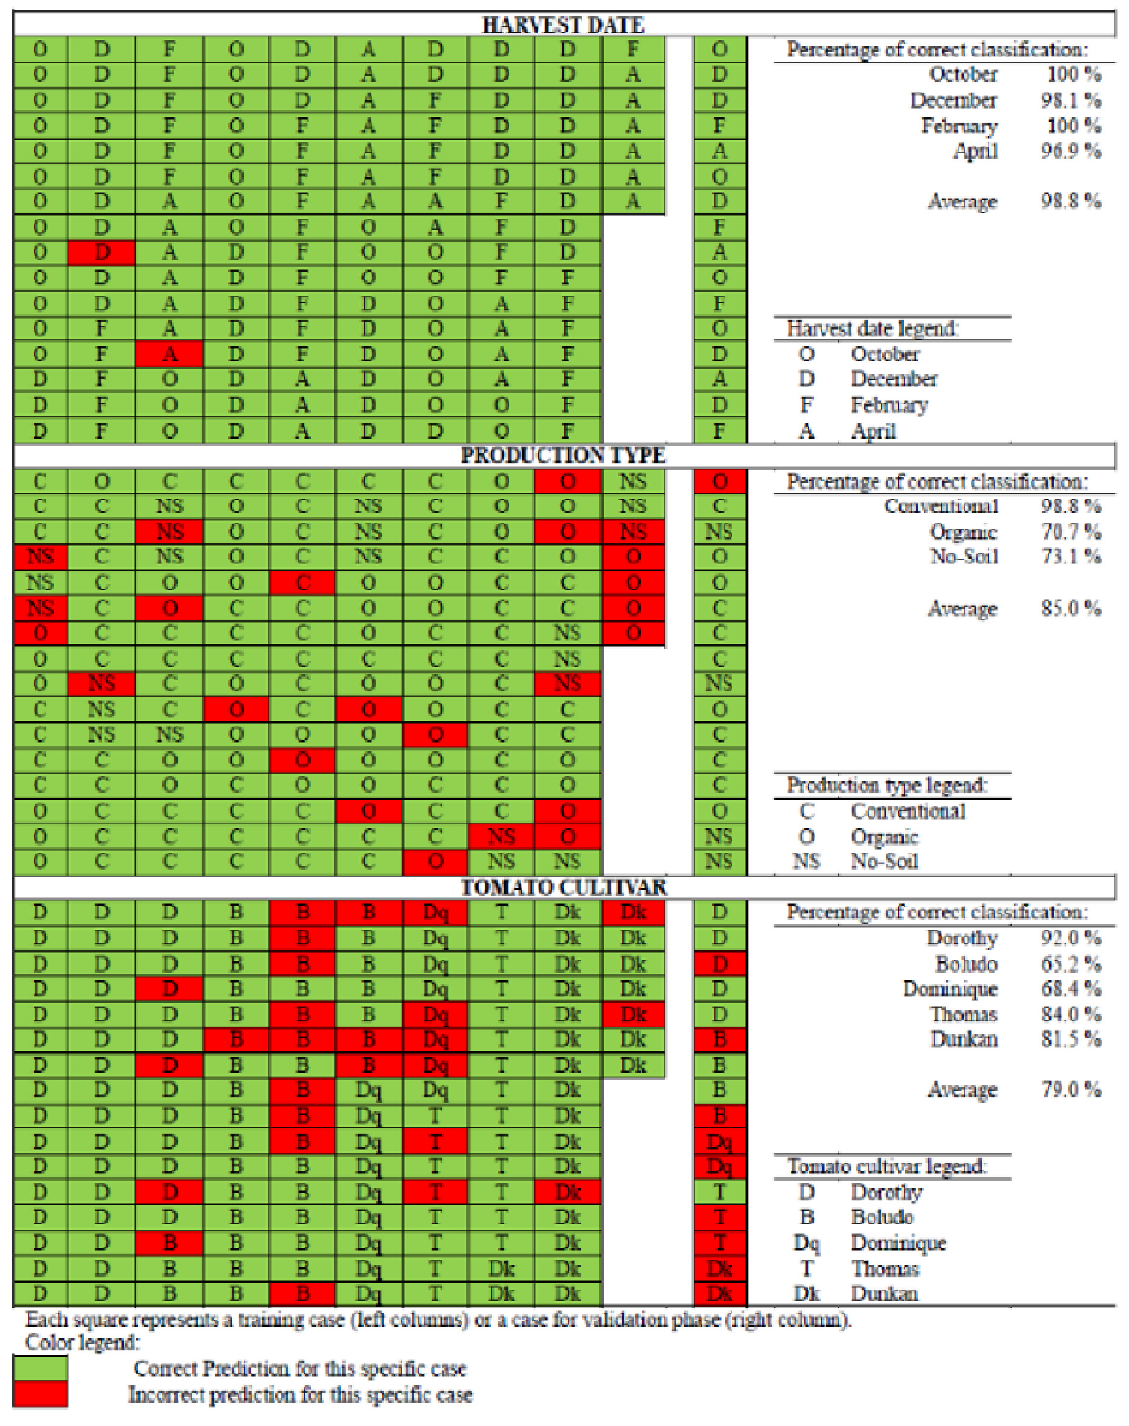
Fig 3. Individual classification for each factor according to prediction models selected to predict the harvests date (D) ANN 4 10-18-1, the production type (P) ANN 3 10-9-3, and the tomato cultivar (C) ANN 3 10-13-3. The left block (ten columns) shows the samples for the training phase (151 cases) and the right block (one column) are the samples for the validation phase (16 cases). The cases correctly classified are highlighted in green whilst the incorrectly classified are in